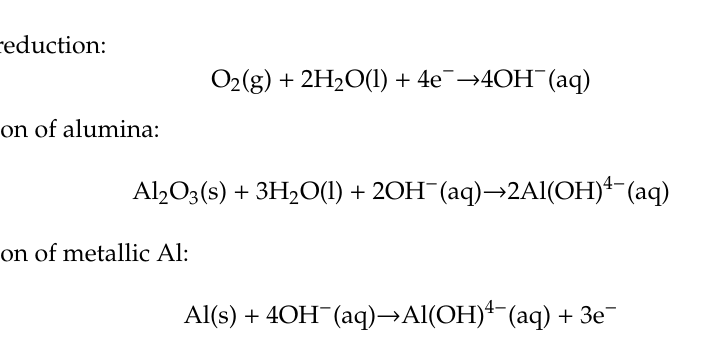
Figure 8. ( a ) XPS survey spectrum and ( b – e ) high-resolution spectra of the surface on AlSi-MC after the PS test.